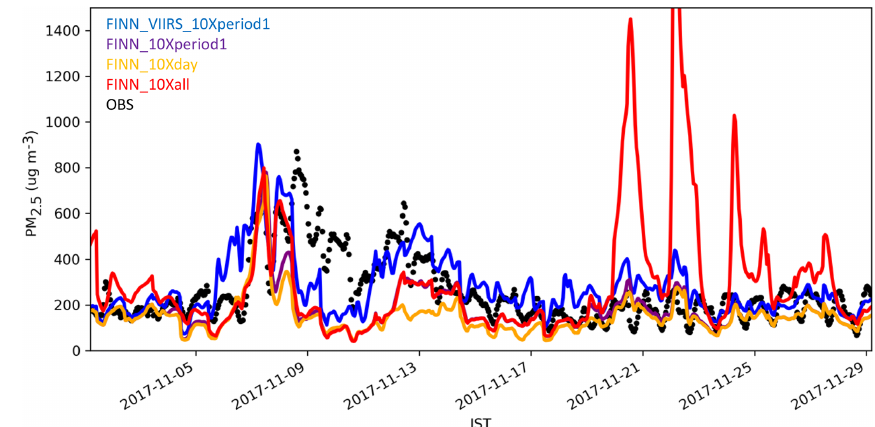
Figure 10. Time series of model PM 2 . 5 sensitivity to a 10-times increase in the FINN emission inventory for different periods: FINN_VIIRS_ 10Xperiod1, 3 to 17 November; FINN_10Xperiod1, 3 to 17 November; FINN_10xday, 5 November; and FINN_10Xall, all days. Black dots represent ground measurement data averaged over all CPCB stations in Delhi.